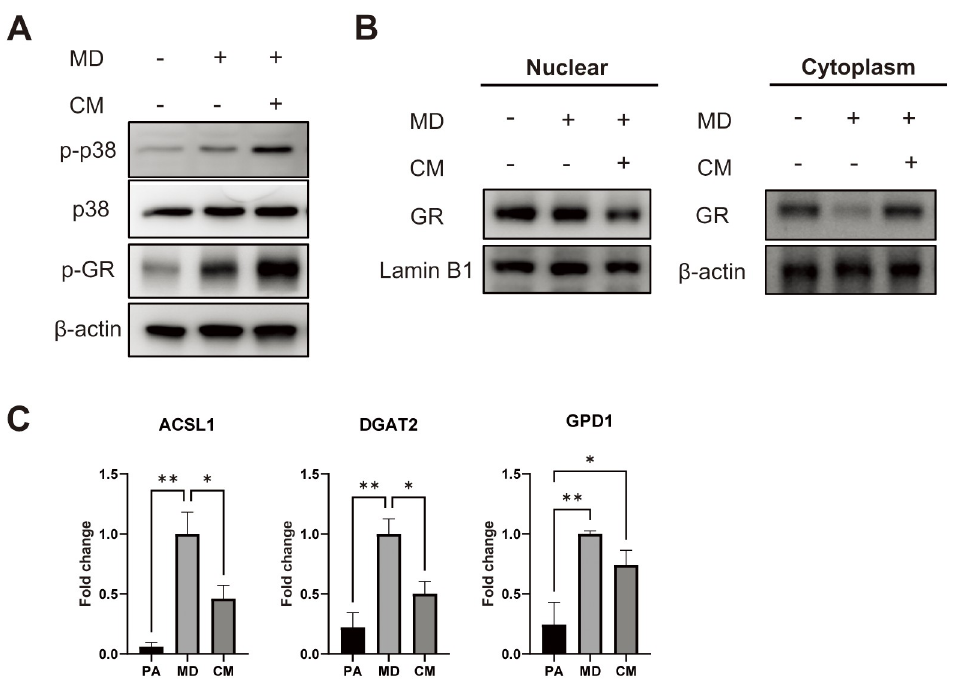
Fig 3. T-MSC CM enhances GR phosphorylation and inhibits its nuclear translocation. (A) Representative Western blots of whole cell lysates treated with MD for 1 h in the presence or absence of T-MSC CM. (B) After 8 h of treatment, cells were divided into nuclear and cytoplasmic fractions, and GR levels were examined by Western blots. (C) mRNA expression of GR-responsive lipid metabolism genes Acsl1, Dgat2, and Gpd1 was determined by RT-qPCR. Data are presented as mean ± SEM and were analyzed using one-way ANOVA (n = 3, � P < 0.05, �� P <